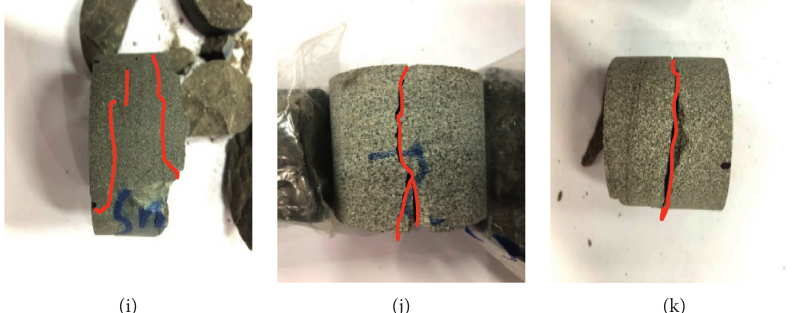
Figure 6: Failure mode diagram of deep sandstone compressive - tensile test. (a) S1-1 Shear failure. (b) S1-2 Tensile failure. (c) S1-3 Tensile failure. (d) S1-4 Tensile failure. (e) S1-5 Tensile failure. (f) S1-6 Shear failure. (g) S1-7 Shear failure. (h) S1-8 Tensile failure. (i) Sm-1 Shear failure. (j) Sm-4 Tensile failure. (k) Sm-5 Shear failure.